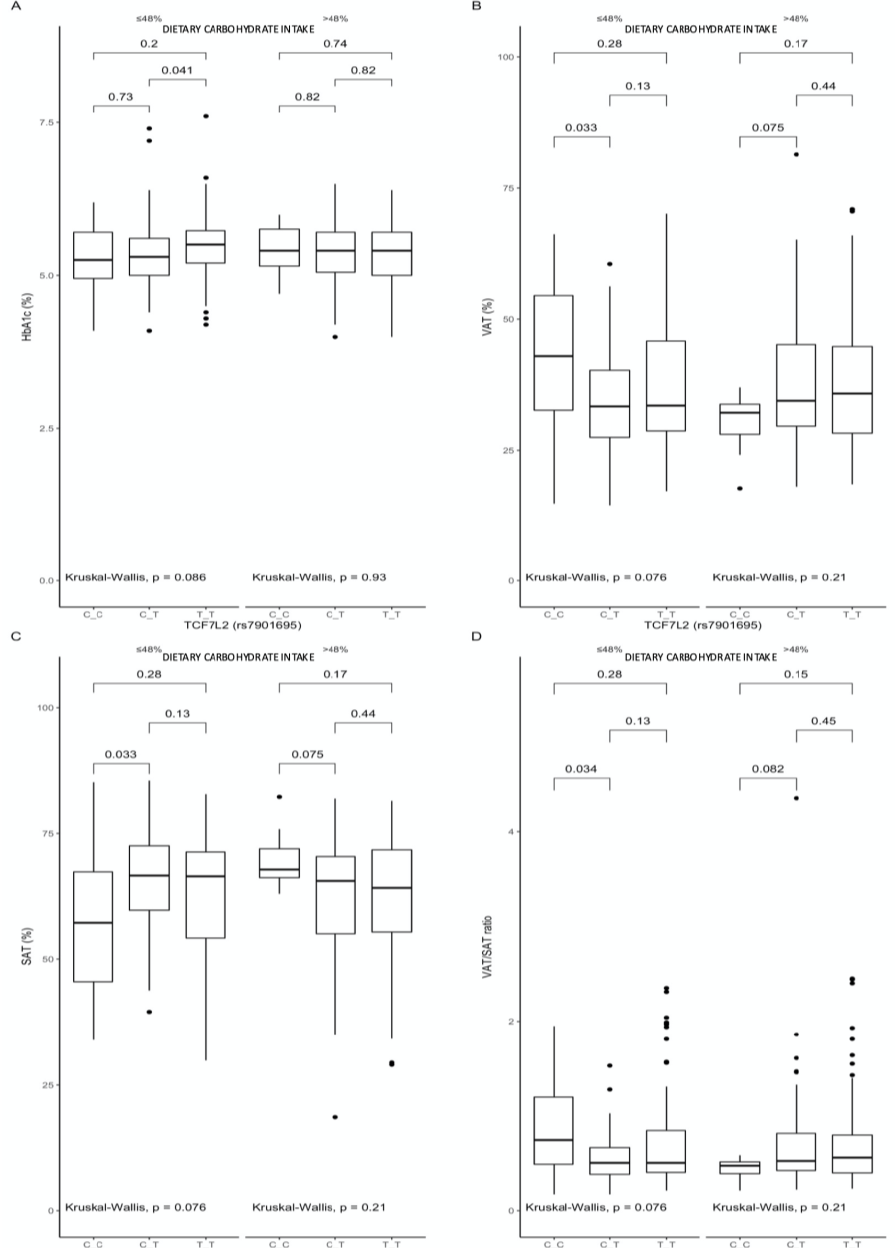
Figure 3. Association of the TCF7L2 rs7901695 genotypes with ( A ) HbA1c (%), ( B ) VAT (%), ( C ) SAT (%), and ( D ) VAT/SAT ratio, by dietary carbohydrate intake strata: ≤48% and >48% of total daily energy intake. The differences in median values of the selected responses and the interquartile ranges (IQRs) in different genotypic and dietary strata are presented. Kruskal–Wallis test p -values for the differences in median values within three strata are presented.